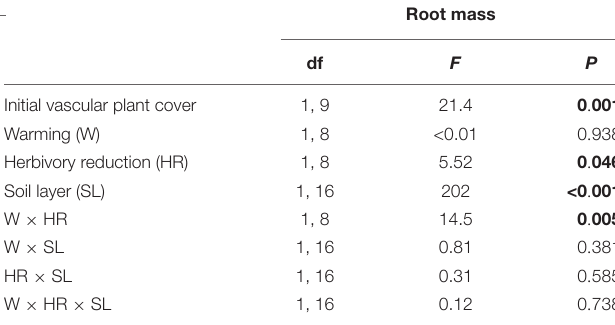
TABLE 1 | F and P statistics of the effects of warming (ambient, +3 ◦ C), herbivory TABLE 2 | F and P statistics of the effects of warming (ambient, +3 ◦ C), herbivory reduction (normal, reduced) and initial vascular plant cover on the total shoot reduction (normal, reduced), soil layer (organic soil, 0 − 5 cm mineral soil, > 5 cm abundance and root-to-shoot allocation of field layer vascular plants (block was mineral soil) and initial vascular plant cover on total root mass of field layer included in the model as a random factor and the initial soil NH 4 + concentration as vegetation (block was included in the models as a random factor, and moss cover, an additional covariate, but these effects are not reported; P < 0.05 are in bold). soil OM content and soil PO 43 − concentration as additional covariates, but these effects are not reported; P < 0.05 are in Shoot abundance Root-to-shoot allocation